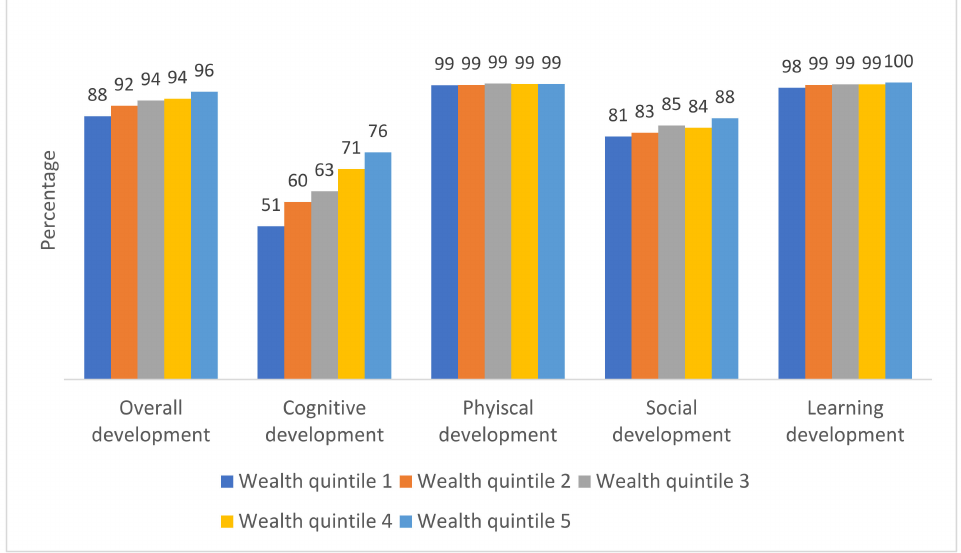
Figure 2. Percentage of children by wealth quintile who achieved appropriate ECD index by four